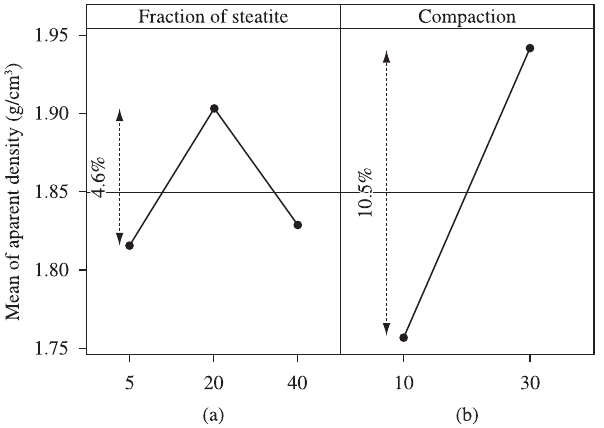
Figure 2. Interaction effect plot for linear shrinkage, fraction of steatite and compaction.